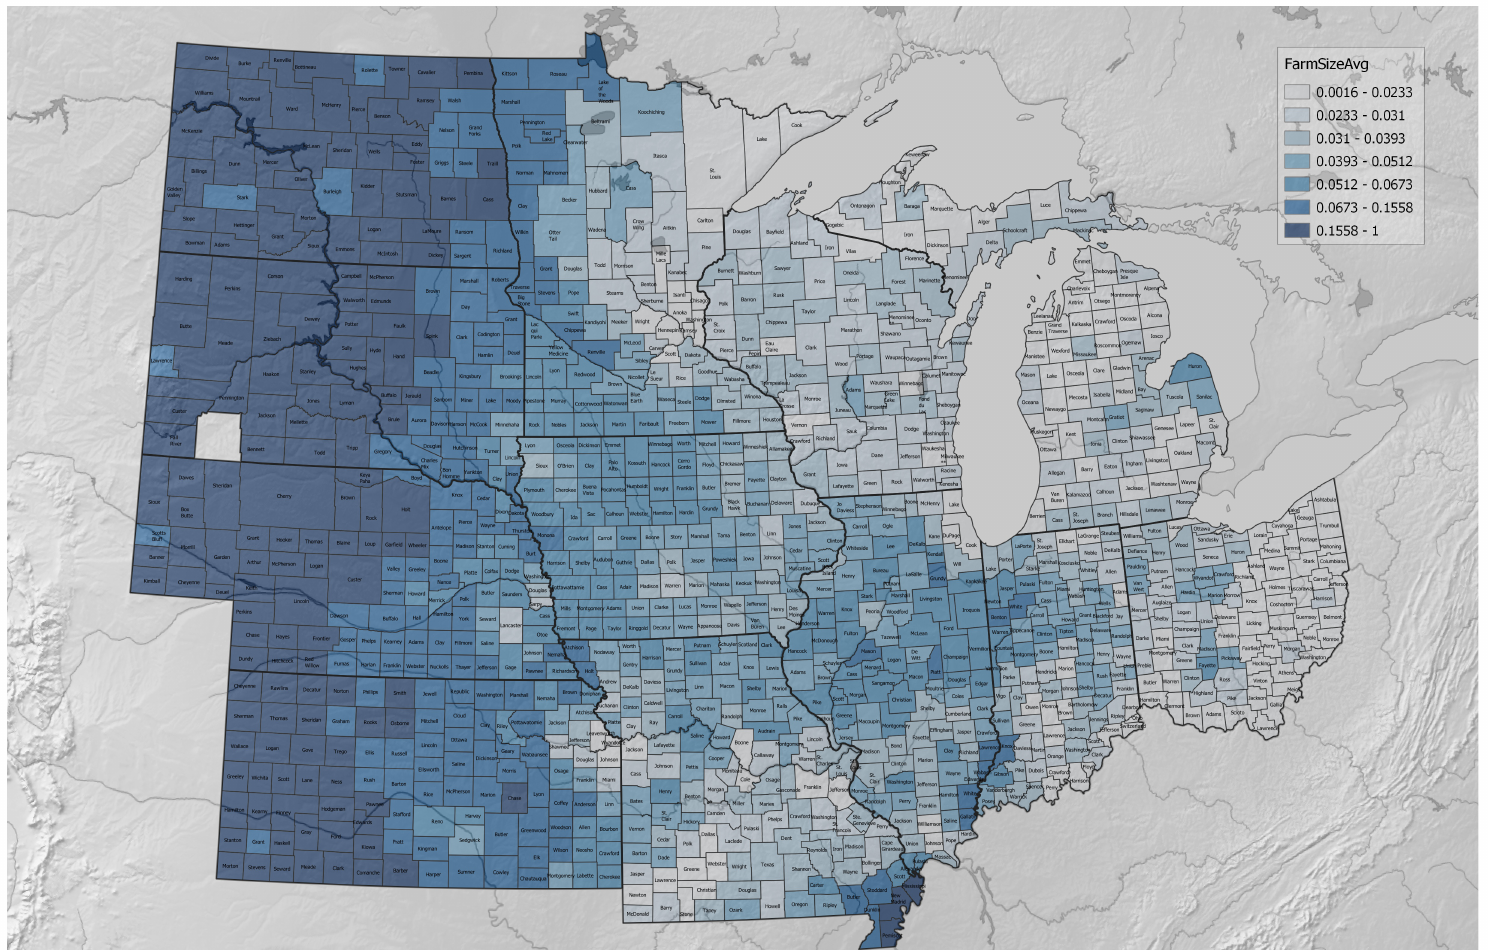
Figure A9. Average land area per farm, by county, 2017. Values were all rescaled through dividing by the largest value present for any of the counties included here (7736 acres per farm in Grant County, Nebraska), as this transformation was applied to the variable data as they were placed into the index expression. Methods for FarmSizeAvgAcres are described in the article main text and Supplementary Materials. USDA 2017 Census of Agriculture data [52] were